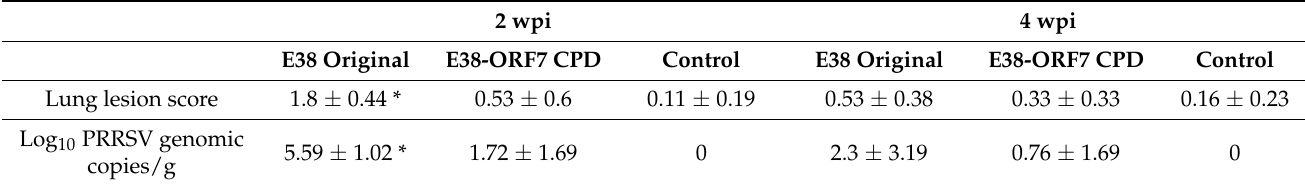
Figure 3. Assessment of the virulence and immune response induced by E38-ORF7 CPD and original virus: Three-week-old pigs were administration with 2 mL of 10 5 TCID50/dose attenuated virus (E38-ORF7 CPD) and original virus. The pigs were monitored for clinical signs, rectal temperatures, average daily weight gain, antibody levels, and viral copy number. ( A ) Rectal temperature ( ◦ C) of the pigs was monitored every day for 5 days. ( B ) Average Daily Weight Gain (ADWG) post-inoculation of the attenuated (E38-ORF7 CPD) and original virus (E38). There was no statistically significant difference between animal groups inoculated with the attenuated virus and or original virus and the control group. ( C ) Serum genomic copy numbers (PRRSV) in the animals inoculated with attenuated virus and or original virus. The statistically significant difference between the two groups is depicted as *, where p < 0.05. ( D ) SV-specific antibody level (ELISA S/P ratio) in the animals inoculated with attenuated and the original virus (E38). Table 4. Summary of the results regarding gross lung lesions and viral load in